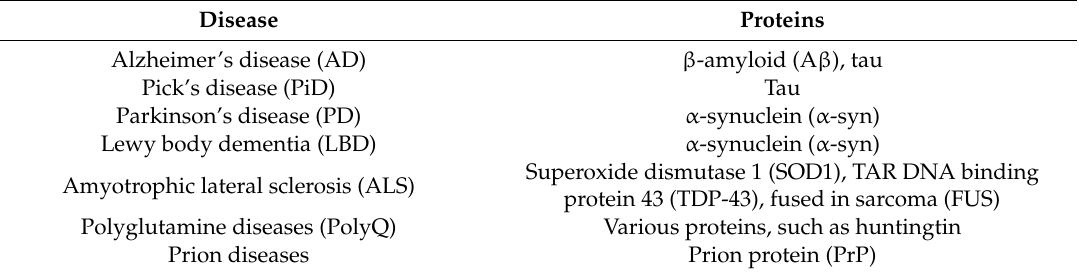
Table 1. Selected protein misfolding diseases and the proteins